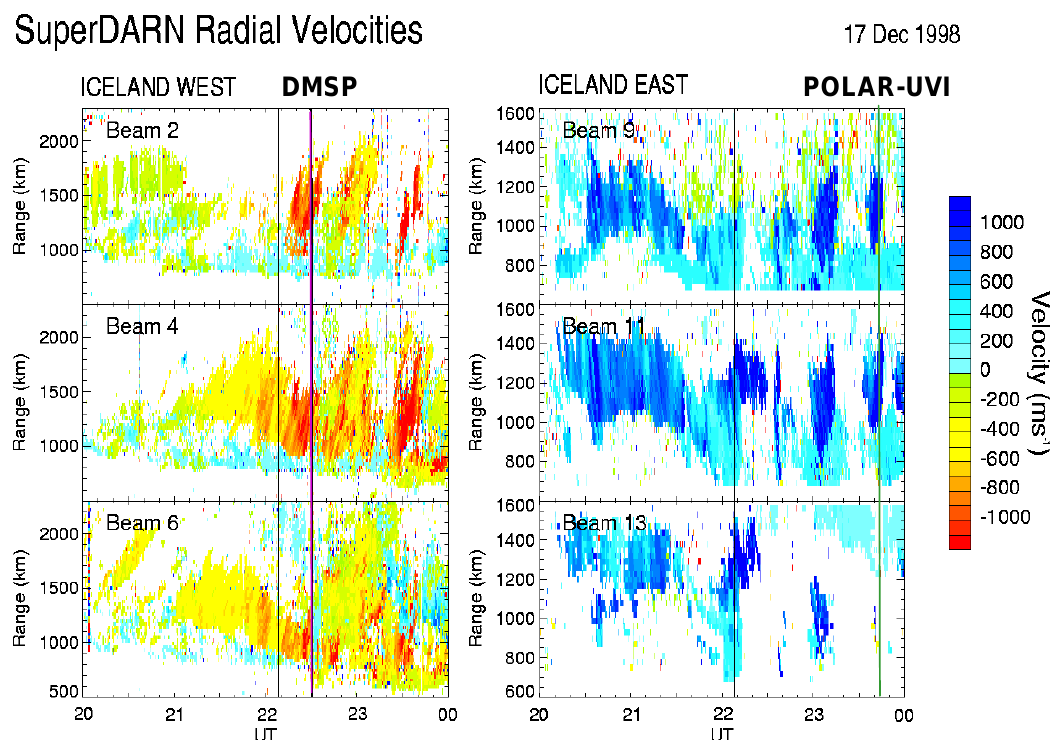
Fig. 3. Range-time plots of the radial velocities along the three high-time resolution beams from the two radars in Iceland. Positive (negative) velocities indicate a flow towards (away from) the radar. The vertical line at 22:09UT indicates the time of the full maps of the radial velocities shown on Fig. 4. The vertical line at 22:30UT indicates the time of the DMSP pass shown on Fig. 5 and of the POLAR UVI data shown on Fig. 6.